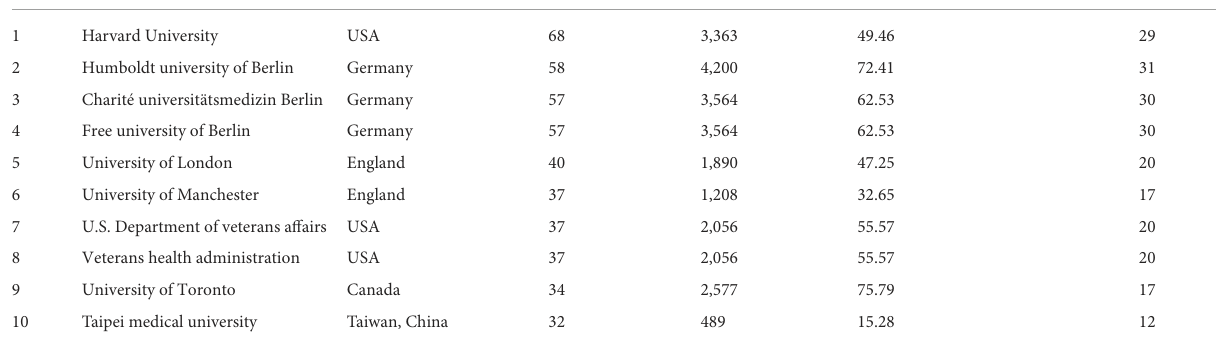
TABLE 2 The top 10 most active institutions that published articles. Rank